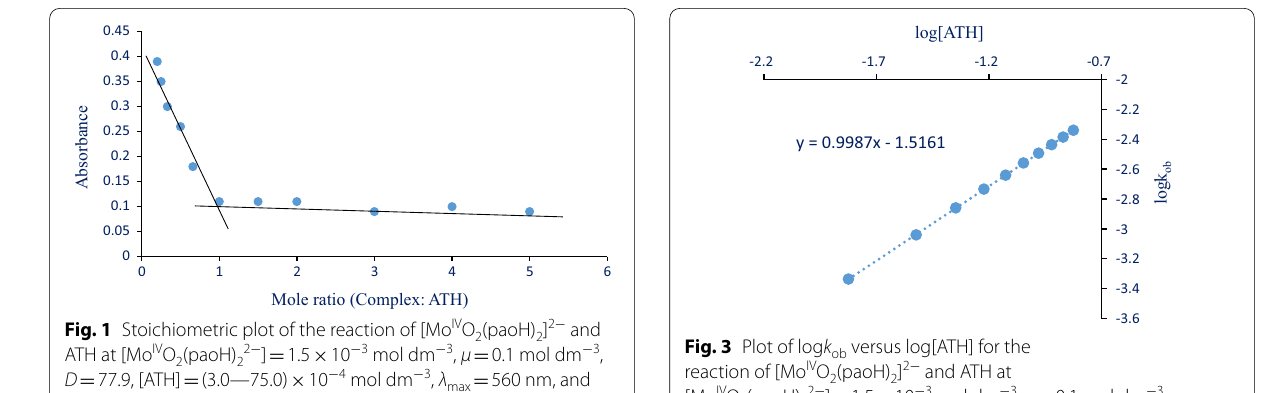
0.1 mol dm − 3 , = 560 nm, and =